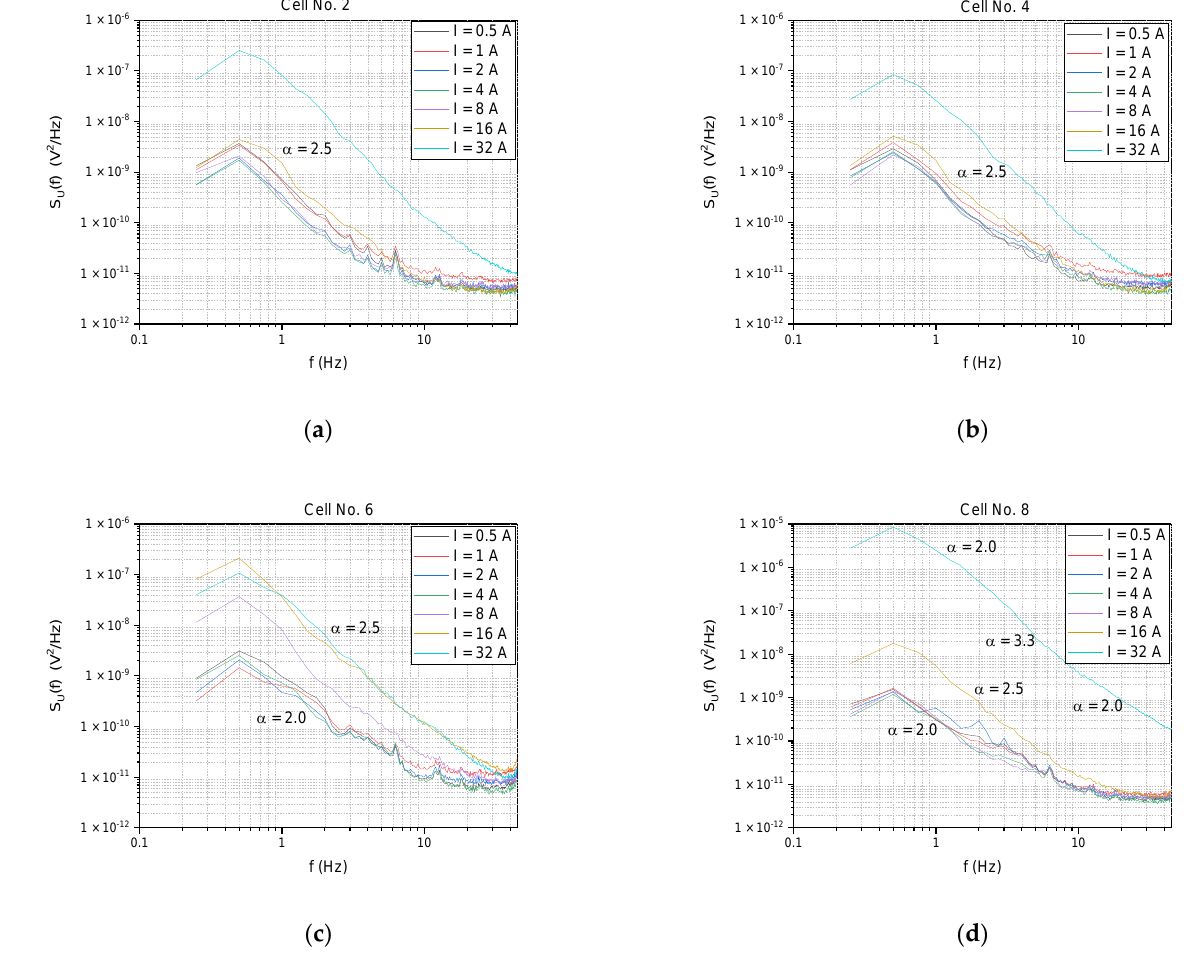
Figure 6. Power spectral density S u (f) of voltage fluctuations observed between the terminals of the cell versus frequency f for different loading currents I: ( a ) cell No. 2, ( b ) cell No. 4, ( c ) cell No. 6, ( d ) cell No. 8.